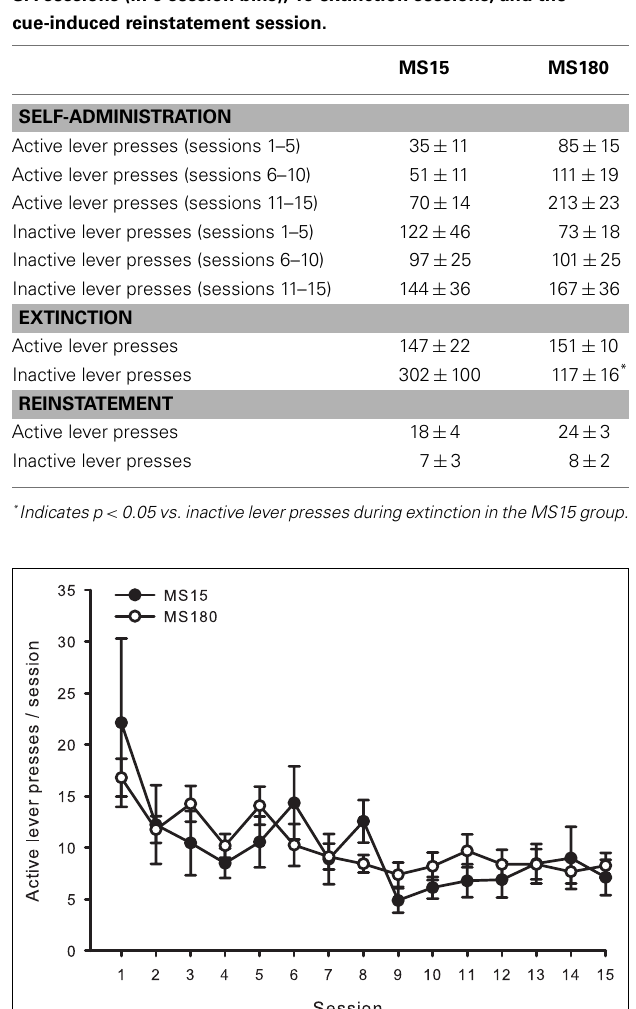
Table 1 | Mean ± SEM active or inactive lever presses across 15 METH